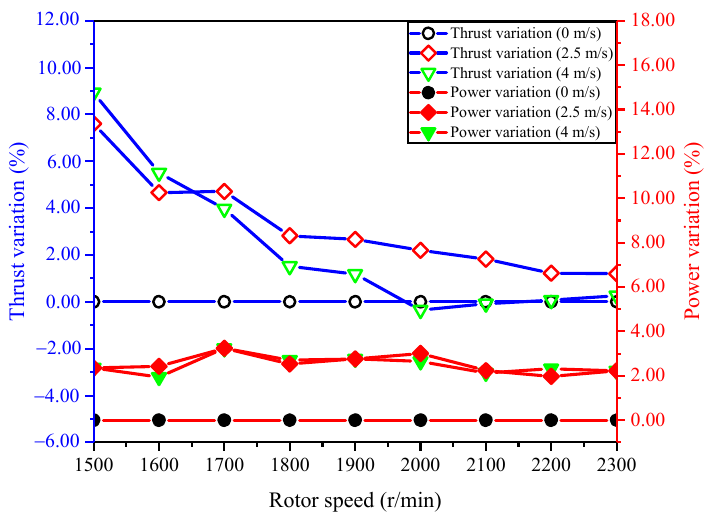
Figure 5. Thrust and power